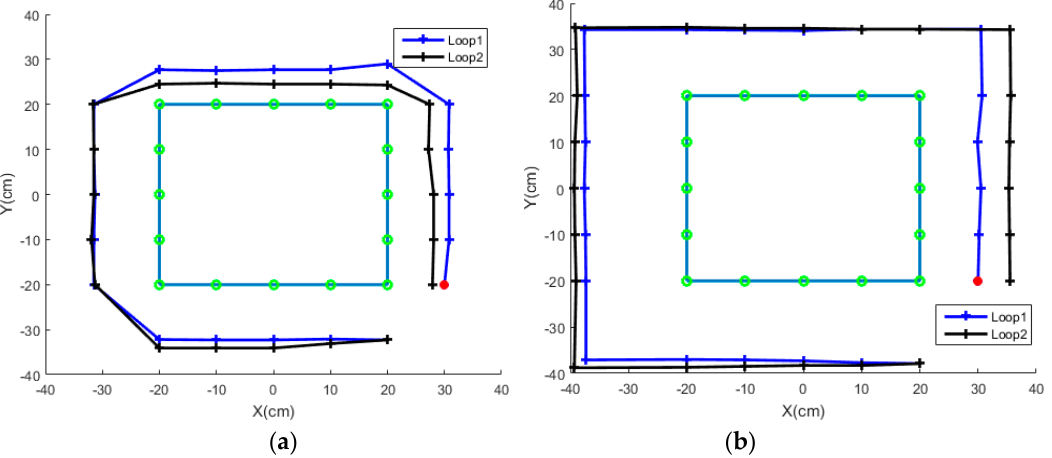
Figure 12. Rectangular route results for sEMG based control by different subjects: ( a ) path traced by S3; ( b ) path traced by S8.